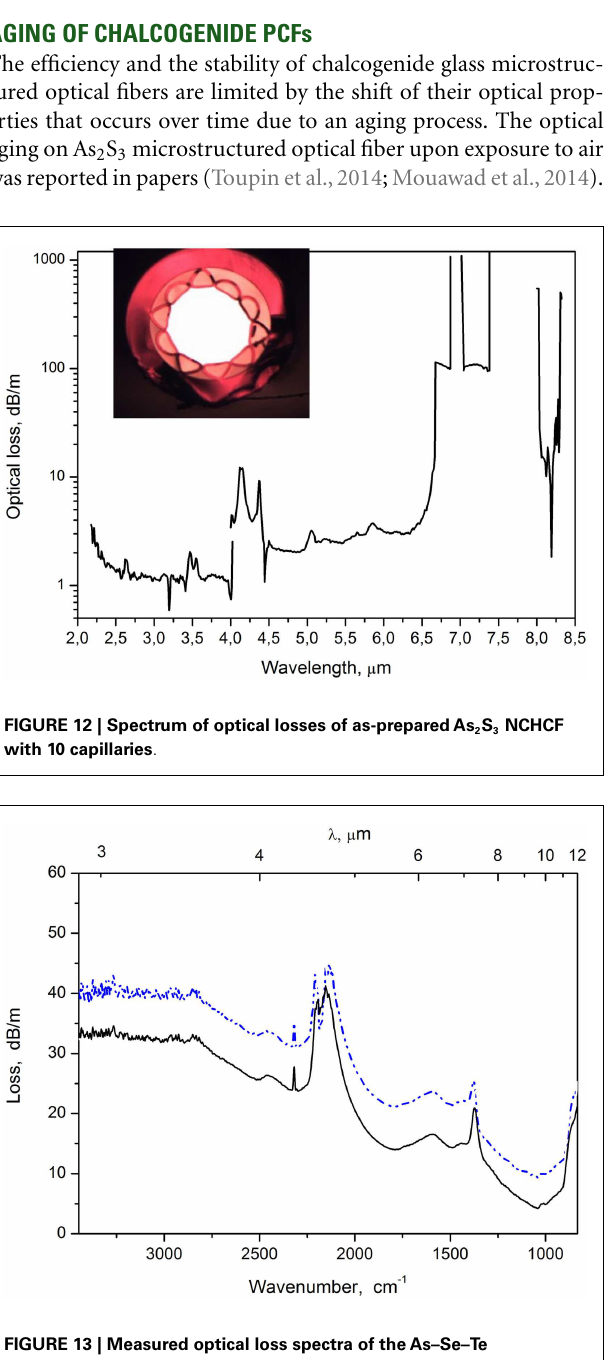
FIGURE 13 | Measured optical loss spectra of theAs–Se–Te microstructured hollow-core fibers (two different pieces) (Kosolapov et al., 2011)